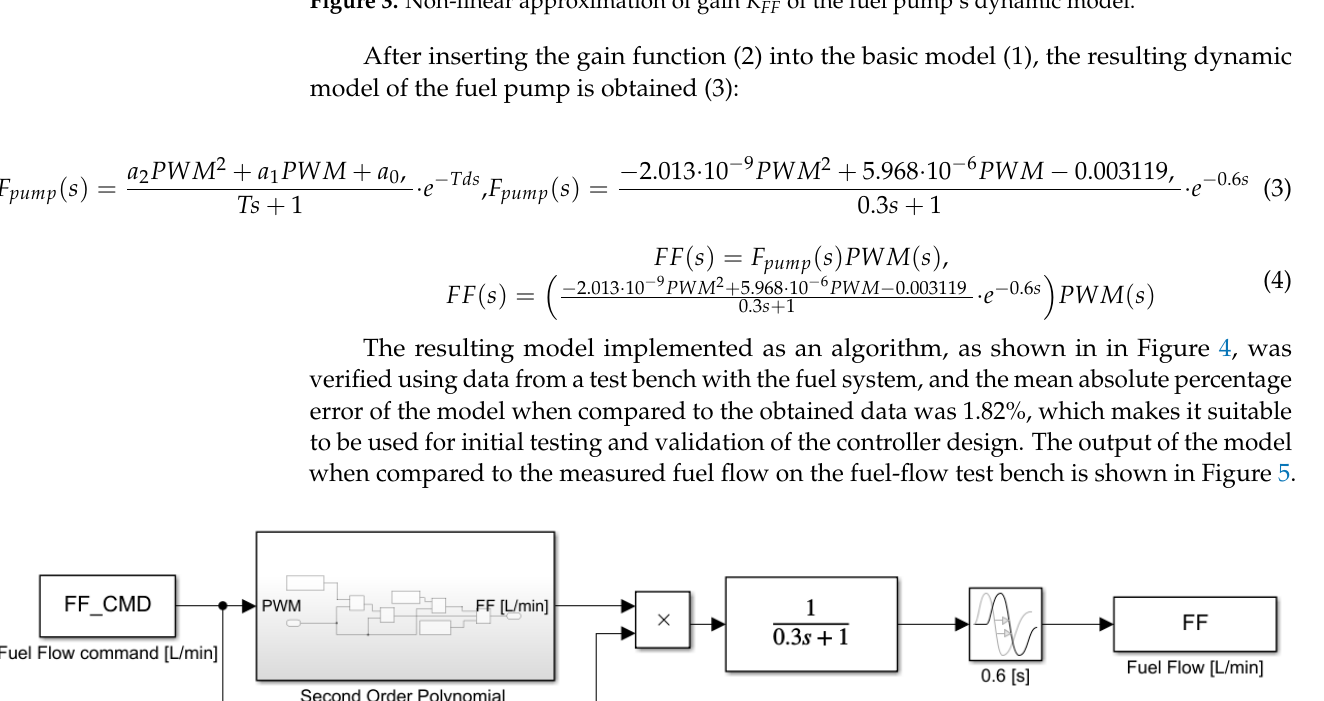
Figure 3. Non ‐ linear approximation of gain K FF of the fuel pump’s dynamic model. Figure 3. Non-linear approximation of gain K FF of the fuel pump’s dynamic model.